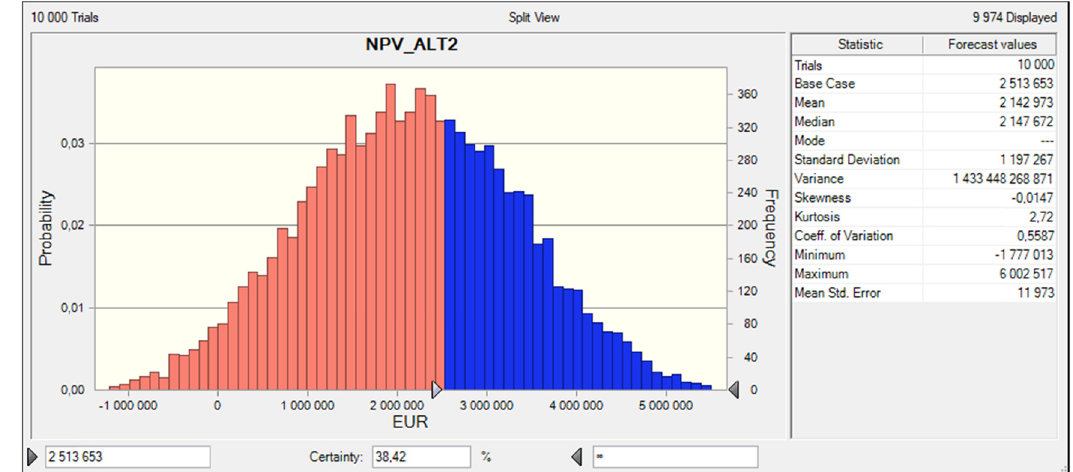
Figure 3: NPV histogram for ALT2.